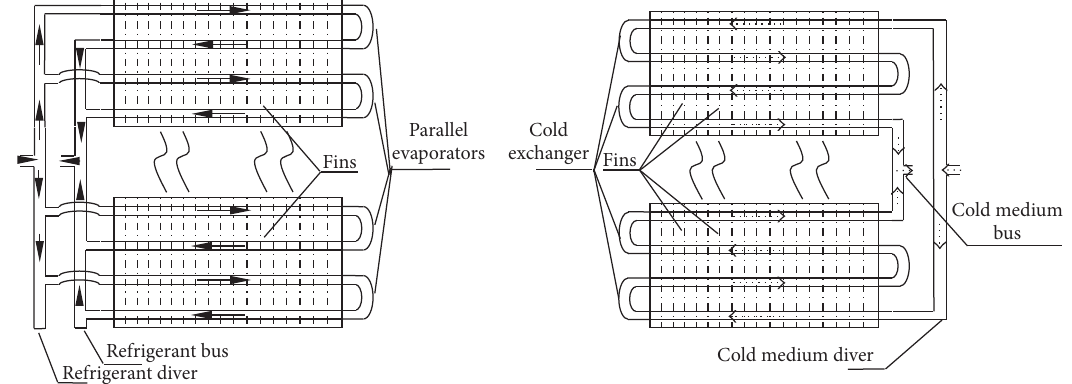
Figure 16: Profile of evaporators and cold exchanger immersed in the ice storage tank.